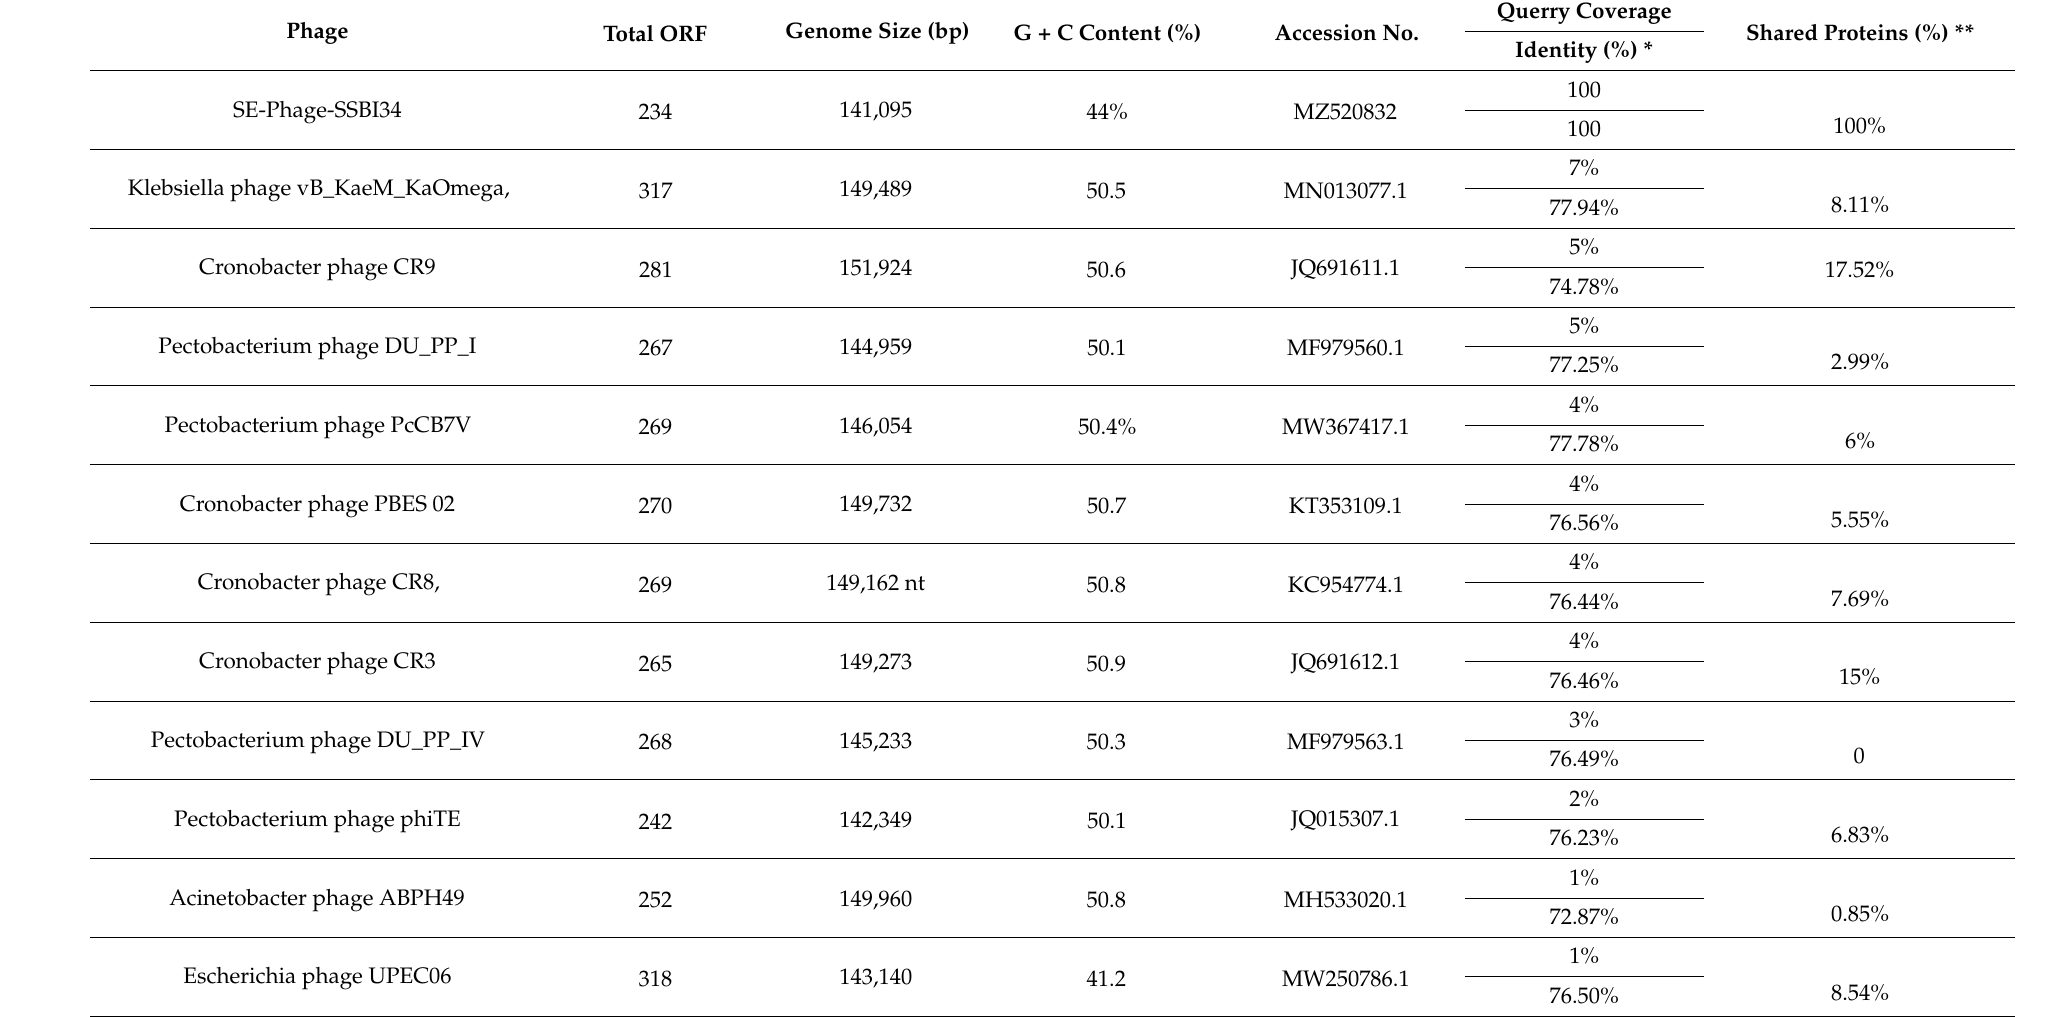
Table 2. Comparison of genome characteristics of SSBI34 with other members of the subfamily Vequintavirinae